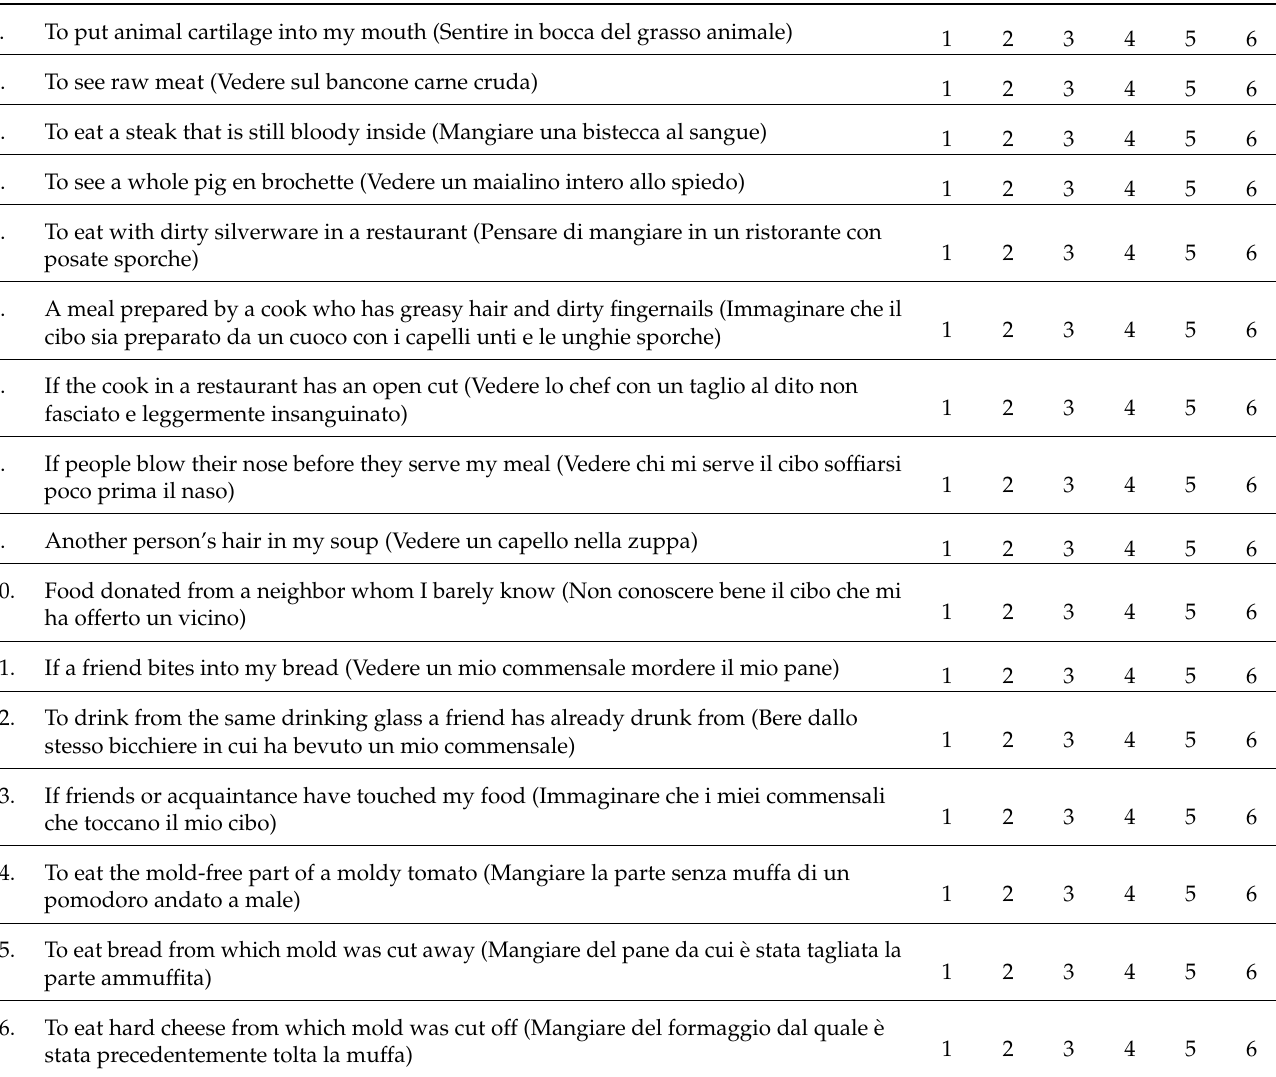
Table A3. Food Disgust Scale (FDS, Hartmann & Siegrist, 2018); in brackets: Italian